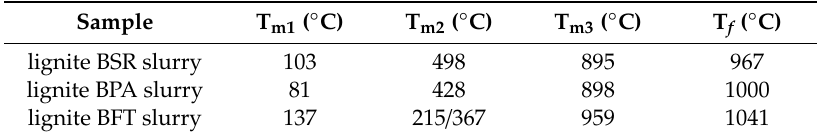
Table 4. Gasification performance indices of biofuels.